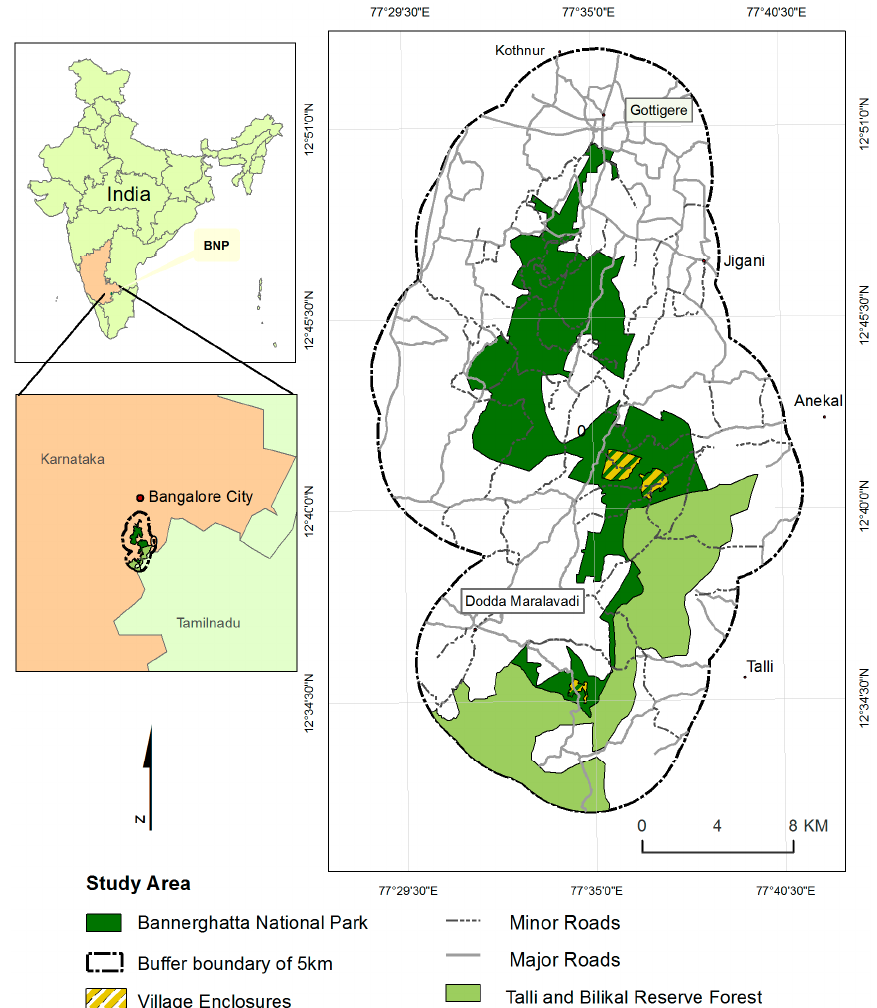
Figure 1. Study region of Bannerghatta National Park and its surrounding, India.